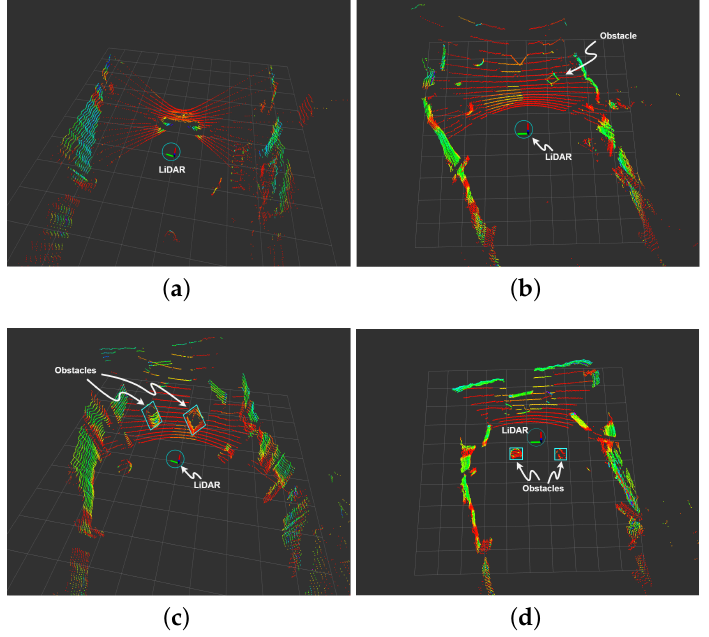
Figure 4. Light Detection and Ranging (LiDAR) point set snapshots at different intervals: starting point of simulation and when the obstacles are visible. ( a ) LiDAR data 1: at the start of the simulation. ( b ) LiDAR data 2: obstacles are starting to enter the detection range. ( c ) LiDAR data 3: obstacles are detected and in close proximity. ( d ) LiDAR data 4: bypassing the